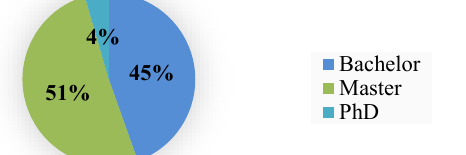
Figure 1. Percentage of bachelor’s, master’s, and doctoral pro- grams in DCH in Europe.